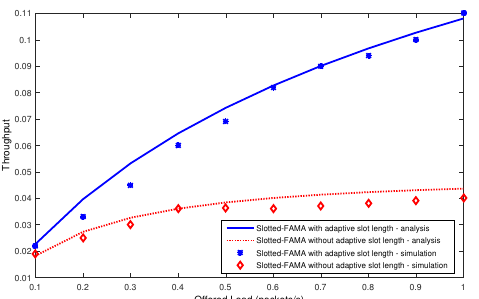
Figure 9. Throughput comparison for Slotted-FAMA with and without adapting the slot length in the network with different